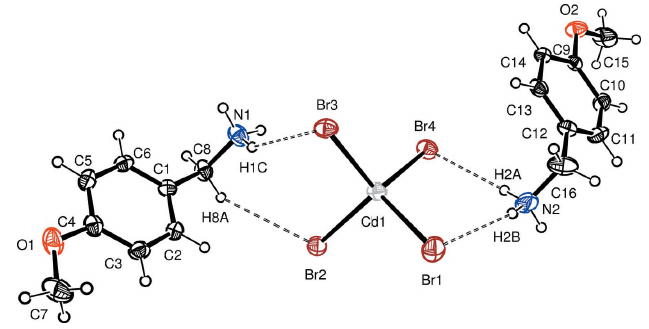
Figure 1 A view of the asymmetric unit of the title compound showing the atom numbering with displacement ellipsoids drawn at the 30% probability level. Dashed lines indicate hydrogen-bonding